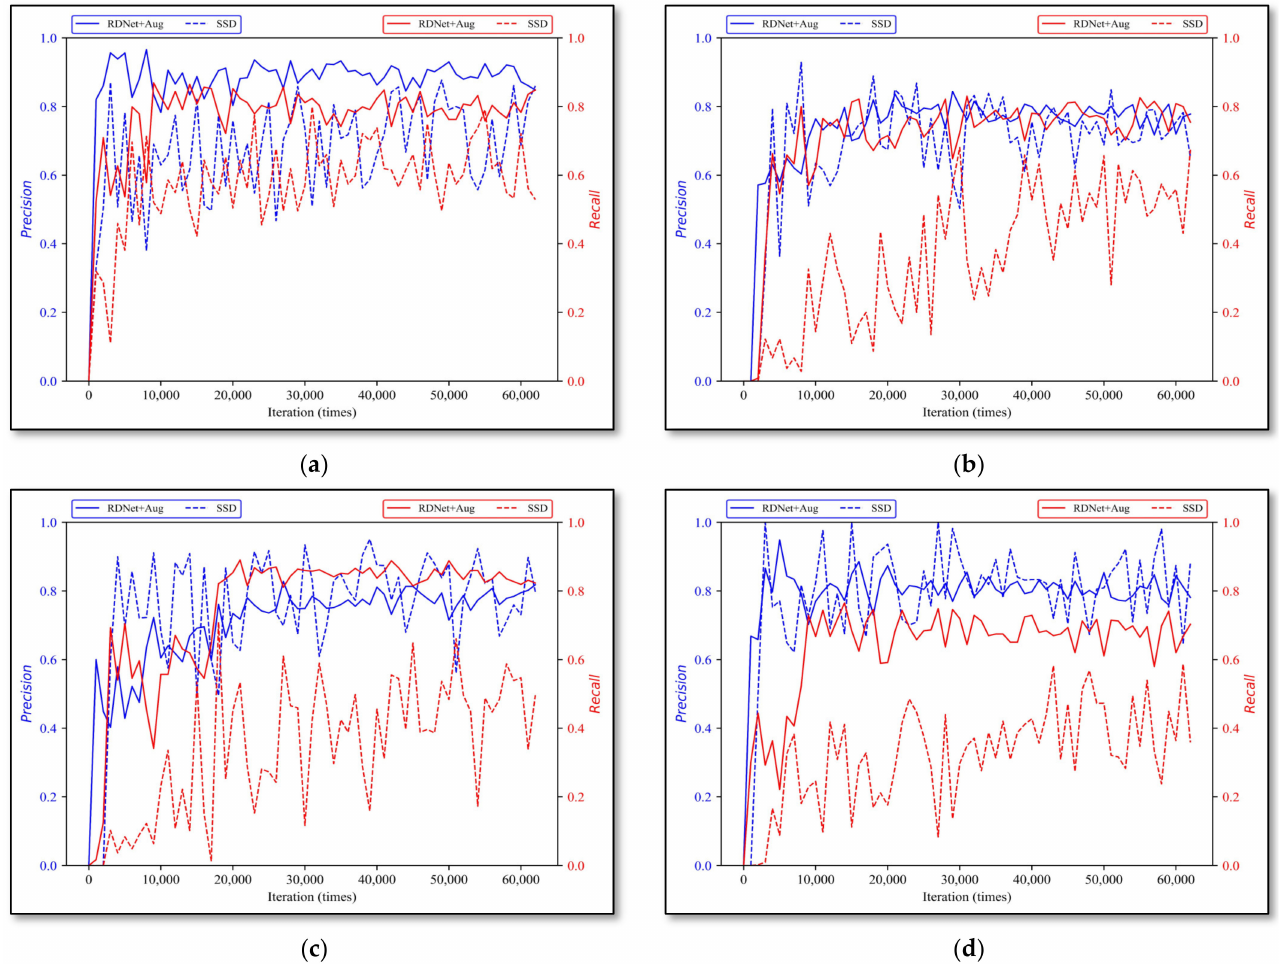
Figure 14. RDNet + Aug and SSD evaluation results. ( a ) monzogranite, ( b ) sandstone, ( c ) shale, and ( d )